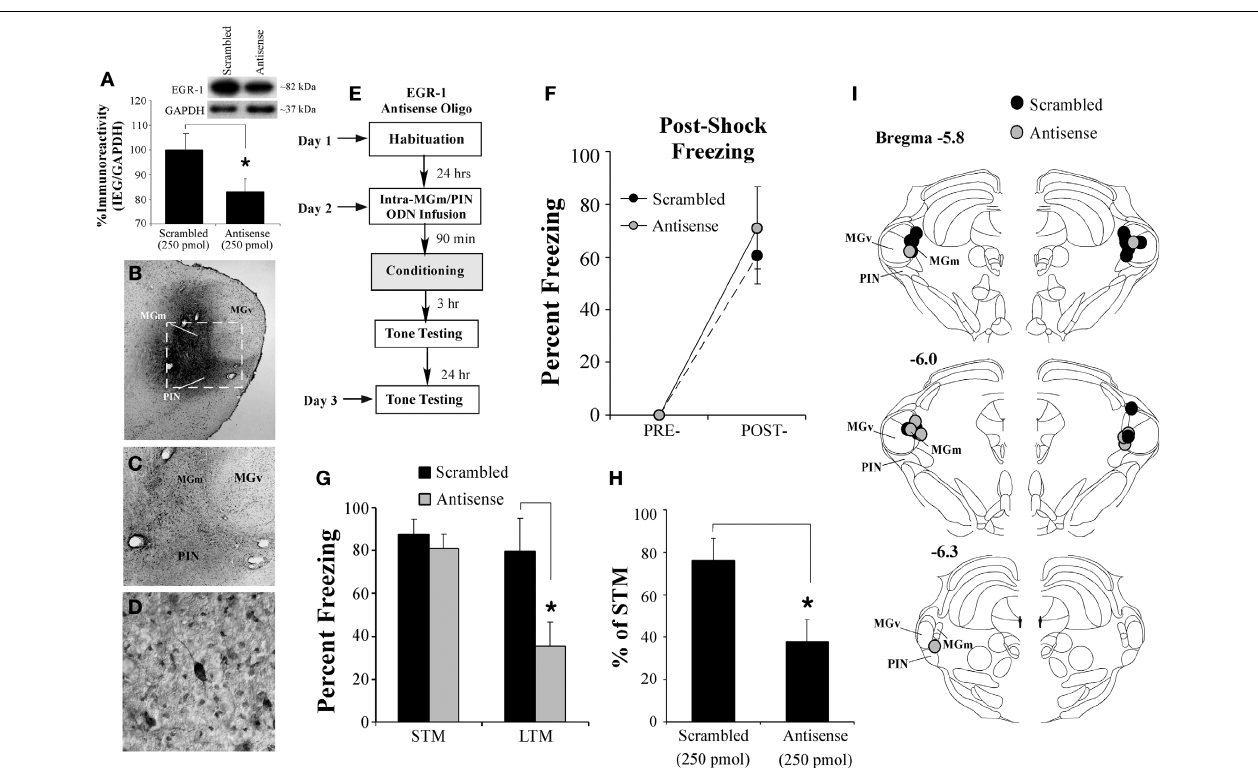
FIGURE 5 | Intra-MGm/PIN infusion of an EGR-1 antisense ODN impairs fear memory consolidation. (A) Western blot analysis of EGR-1 protein in the MGm/PIN of rats given intra-MGm/PIN infusion of scrambled ODN ( n = 10) or EGR-1 antisense ODN ( n = 10). Representative blots can be seen in the inset. * p < 0.05 relative to the scrambled ODN group. (B) Representative 4X photomicrograph of an animal given intra-MGm/PIN infusion of a biotinylated EGR-1 ODN (0.5 µl; 250 pmol) and sacrifi ced 30 min later. Note that the ODN diffusion is largely restricted to the MGm and PIN, and spares the MGv. (C–D) Higher level (20 and 40X, respectively) magnifi cations of MGm/PIN neurons containing biotinylated EGR-1 ODN label from the box in (B) . Note the large number of cells exhibiting uptake of the ODN. (E) Schematic of the behavioral